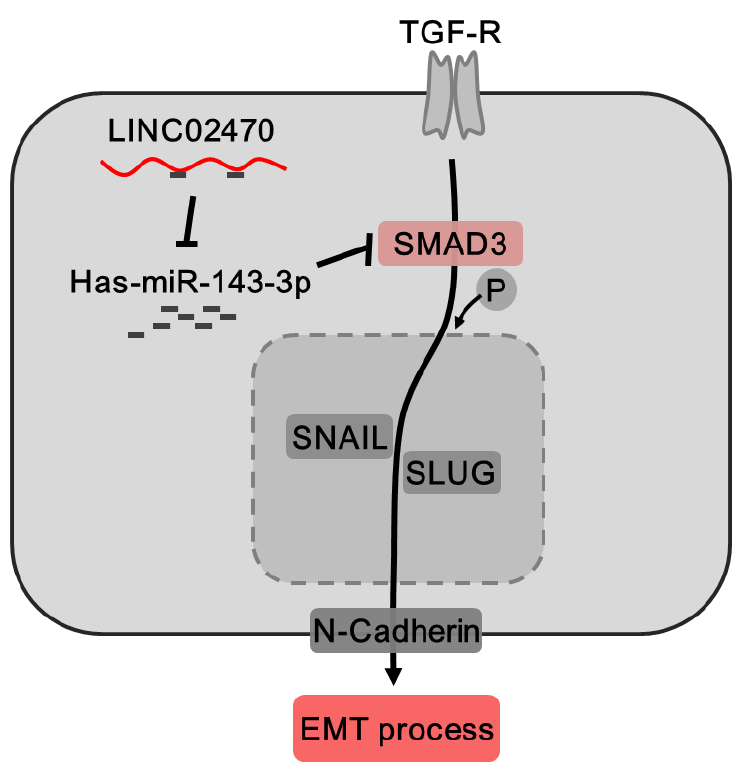
Figure 7. ( A ) Schematic diagram of the LINC02470–miR-143-3p–SMAD3 axis in bladder cancer cells. LINC02470 functions as a miRNA sponge to inhibit miR-143-3p and rescue SMAD3. Subsequently, SMAD3 activates the TGF- β -related EMT process and ultimately aggravates the malignant behav- iors of bladder cancer cells. Therefore, LINC02470 plays an oncogenic role during bladder cancer progression. ( B ) SMAD2/3/4 binding consensus motif in the LINC02470 promoter fragment. Several major components of the TGF- β pathway have been proposed to be directly targeted by miR-143 or miR-145, indicating that they may constitute a negative feedback loop. Among them, miR-145 directly targets SMAD3, a key transcription factor involved in TGF- β responses, which has been confirmed in lung cancer [48]. Similarly, downregulation of miR-145 corresponded to higher SMAD3 expression and EMT process induction in nasopharyngeal cancer cells [49] or inhibited TGF β R2 and SMAD3 in bladder cancer